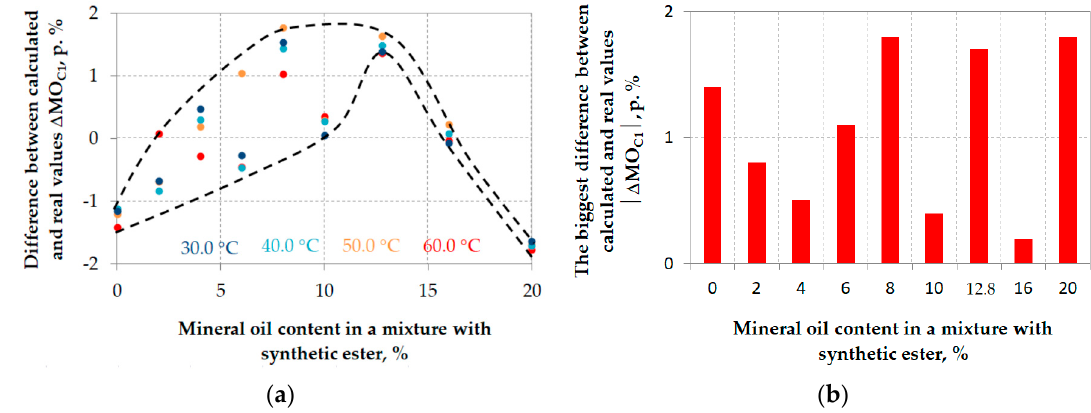
Figure 8. Difference between the real and calculated values of the mineral oil concentration in synthetic ester Δ MO C 1 ( a ) and the absolute values of the biggest differences for all temperatures ⏐ Δ MO C 1 ⏐ ( b ).